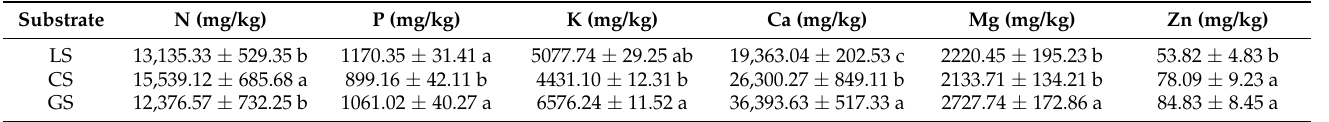
Table 2. Contents of essential roots nutrients of three growth